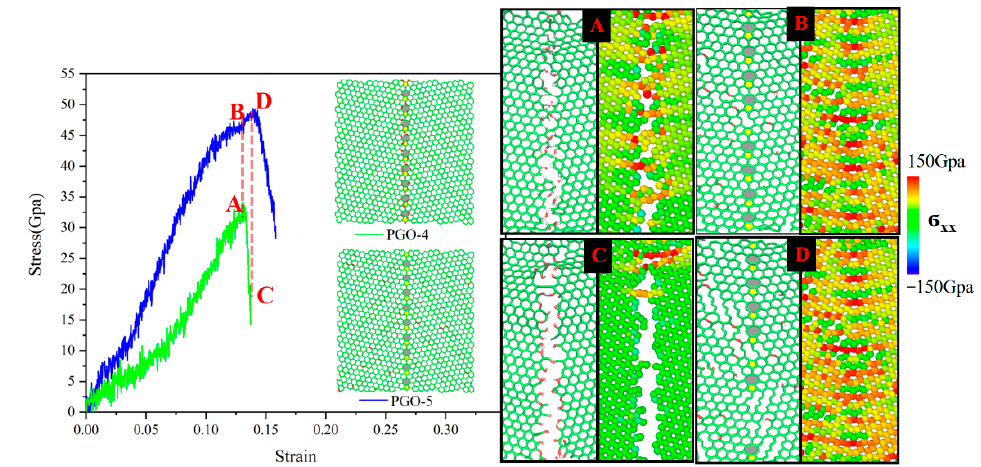
Figure 11. Uniaxial tensile stress-strain diagram and model diagram of pgo-4 and pgo-5 ( left frame ), bond fracture diagram and atomic stress distribution diagram of corresponding marked points ( right frame ). Points A and B: The moment when PGO-4 reaches the ultimate stress; Points C and D: The moment when PGO-5 reaches the ultimate stress.